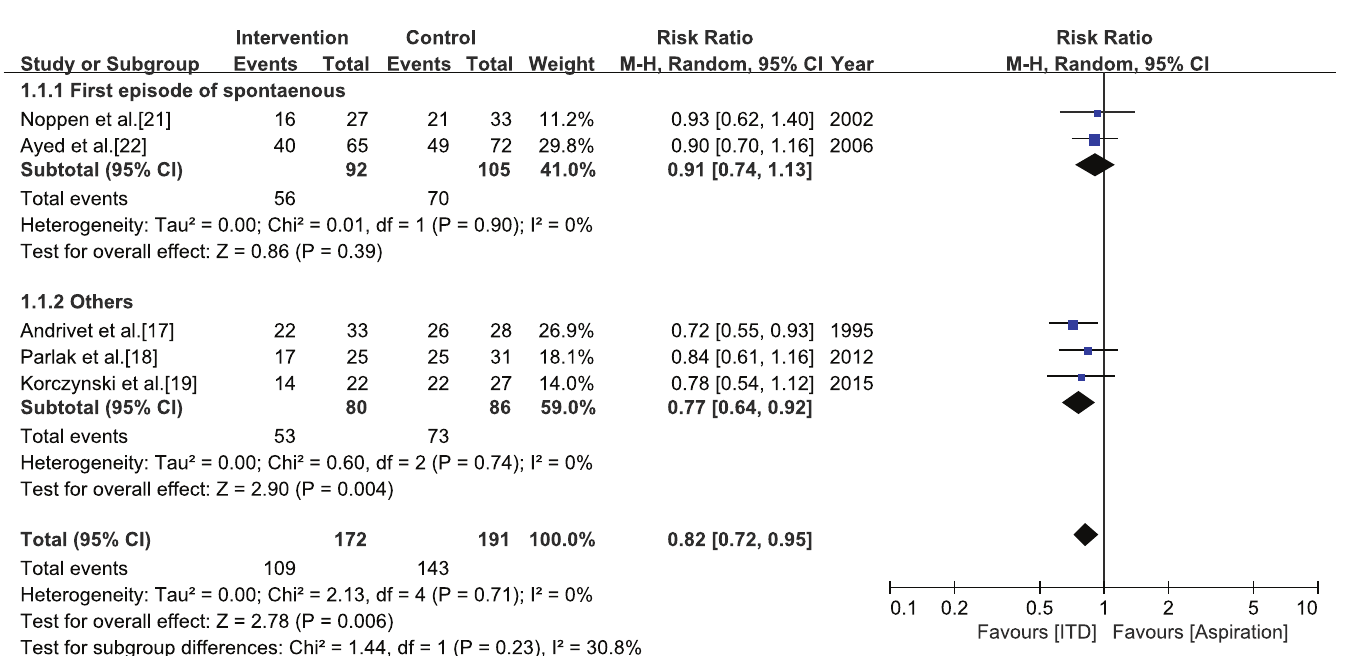
PLOS ONE | https://doi.org/10.1371/journal.pone.0178802 June 22,